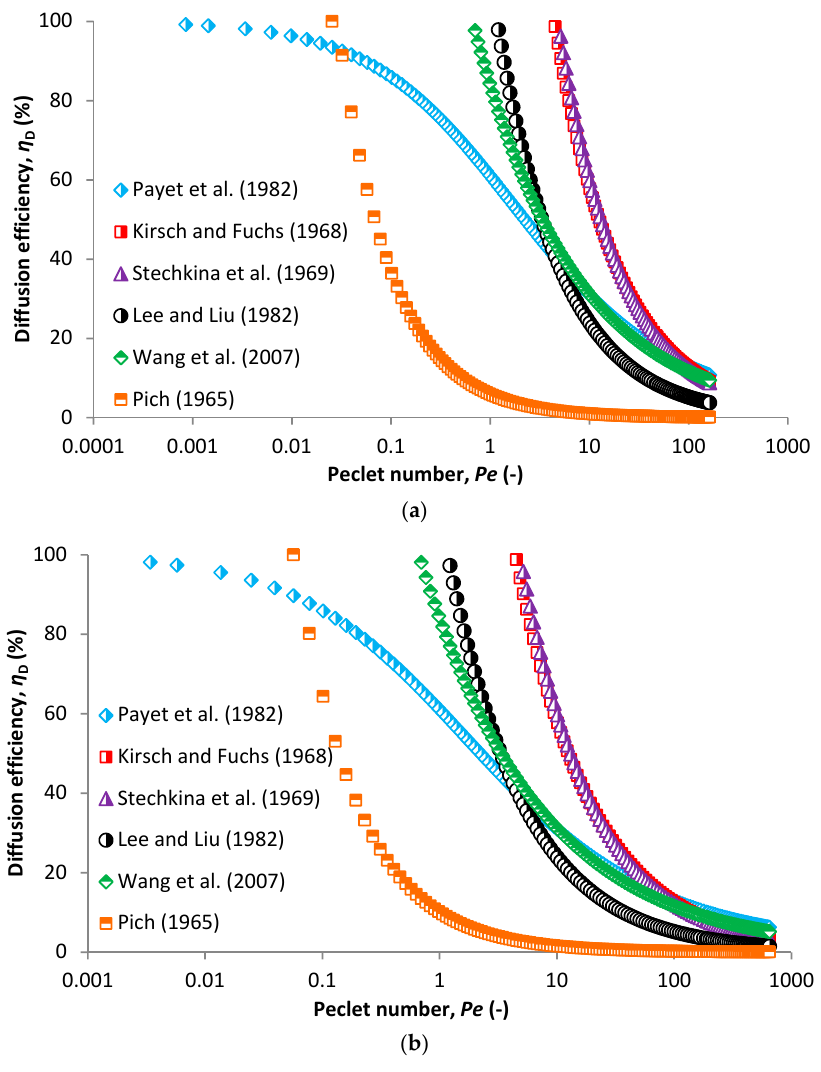
Figure 7. Comparison of SCE due to diffusion mechanisms based on different models for an airflow velocity of 5 cm/s ( a ) and 20 cm/s ( b ) in relation to the Peclet number.